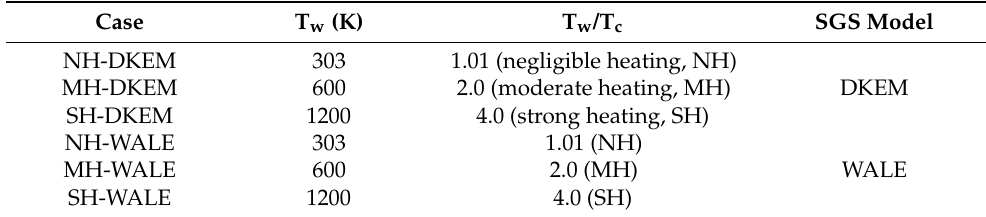
Table 1. Summary of simulations